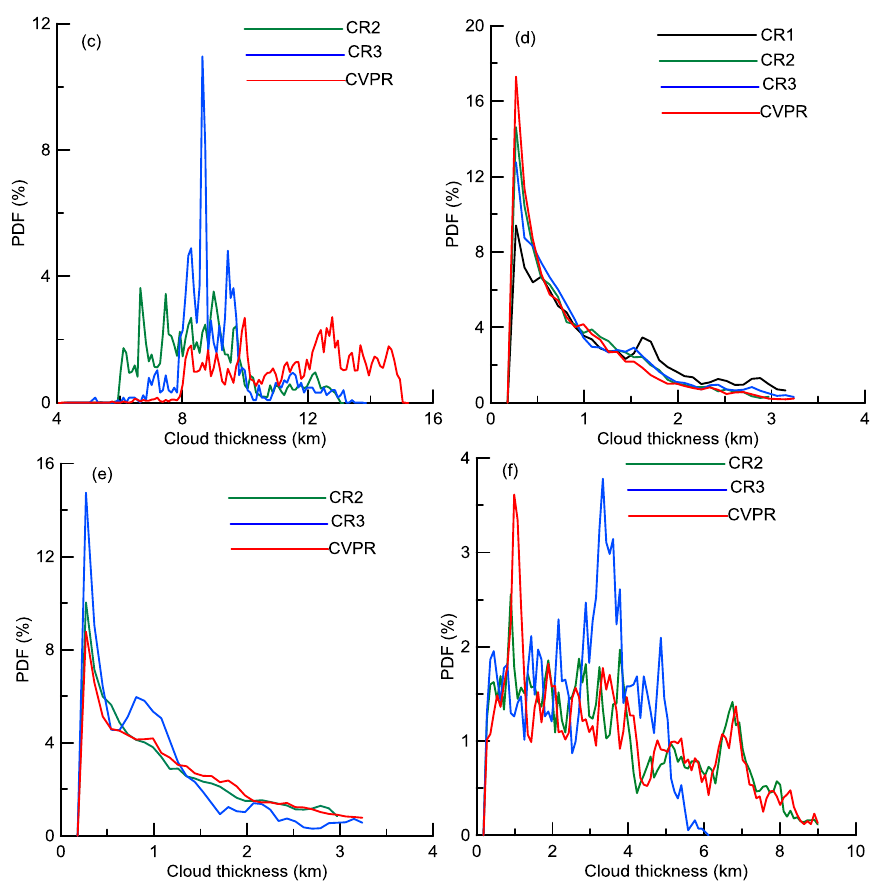
Figure 11. Cloud thickness distribution for precipitating clouds: ( a ) shallow; ( b ) congestus; ( c ) deep clouds and non-precipitating clouds; ( d ) midlevel; ( e ) cirrus and ( f ) anvil by CR and CVPR.